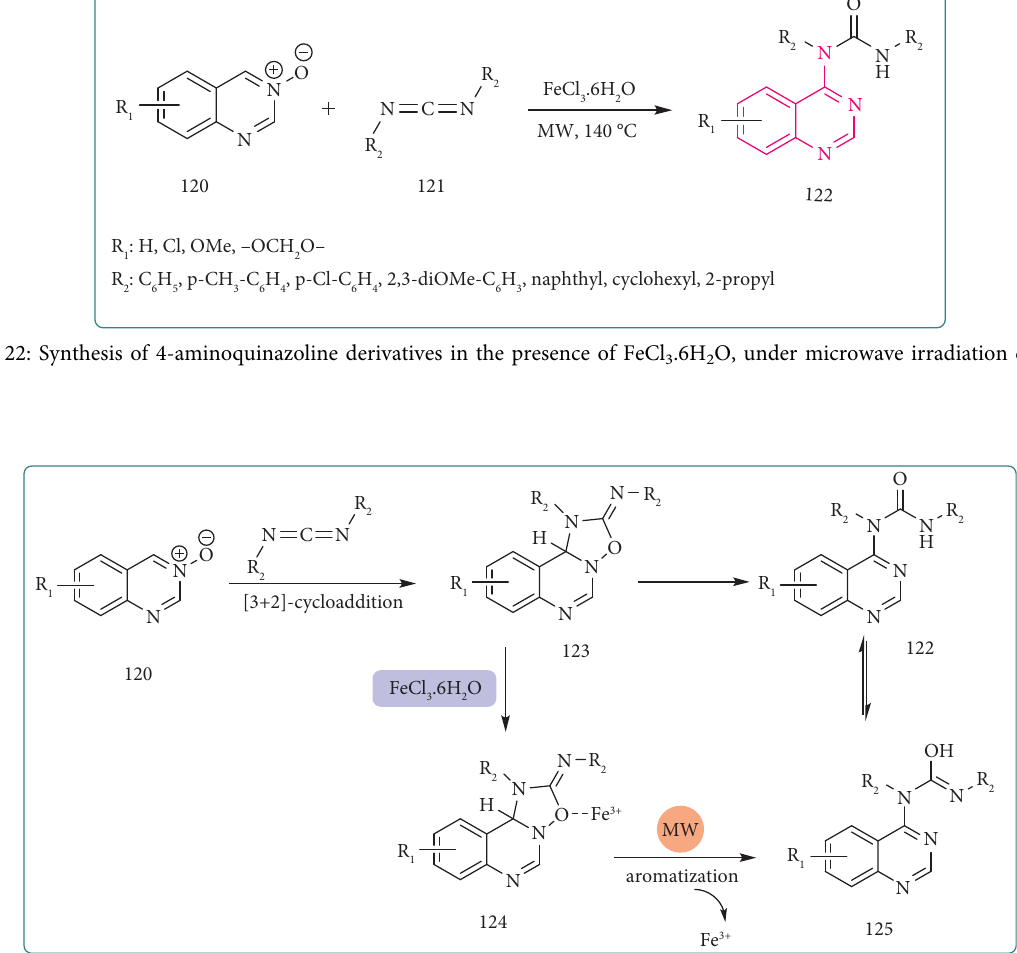
Figure 14: Te proposed mechanism for the synthesis of 4-aminoquinazolines in the presence of FeCl